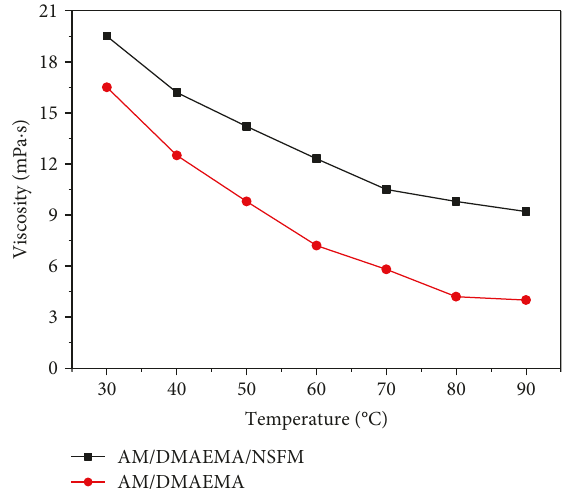
Figure 4: Viscosity versus temperature for AM/DMAEMA and AM/DMAEMA/NSFM solutions. The viscosities of copolymer solutions (0.2 wt%) were measured with a Brook fi eld DV-II viscometer using a no. 63 rotor (rotation speed: 30 rpm).